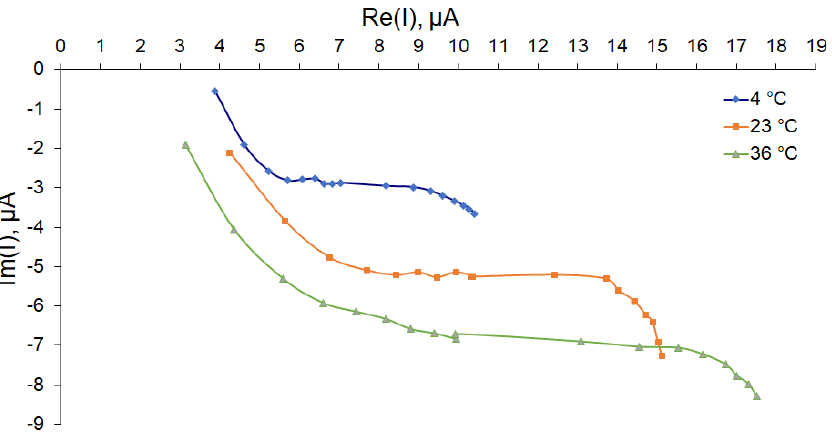
Figure 8. Nyquist plot for the temperature dependence of the impedance of apple nodes.